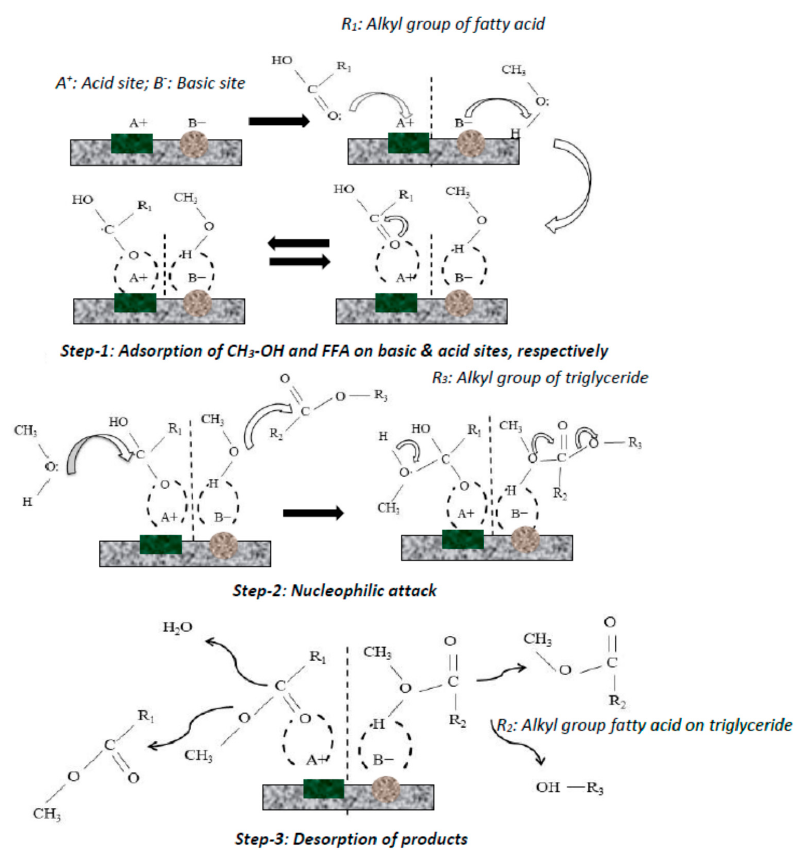
Figure 8. Common mechanism for concomitant esterification and transesterification reactions on a bifunctional heterogeneous catalyst [116].